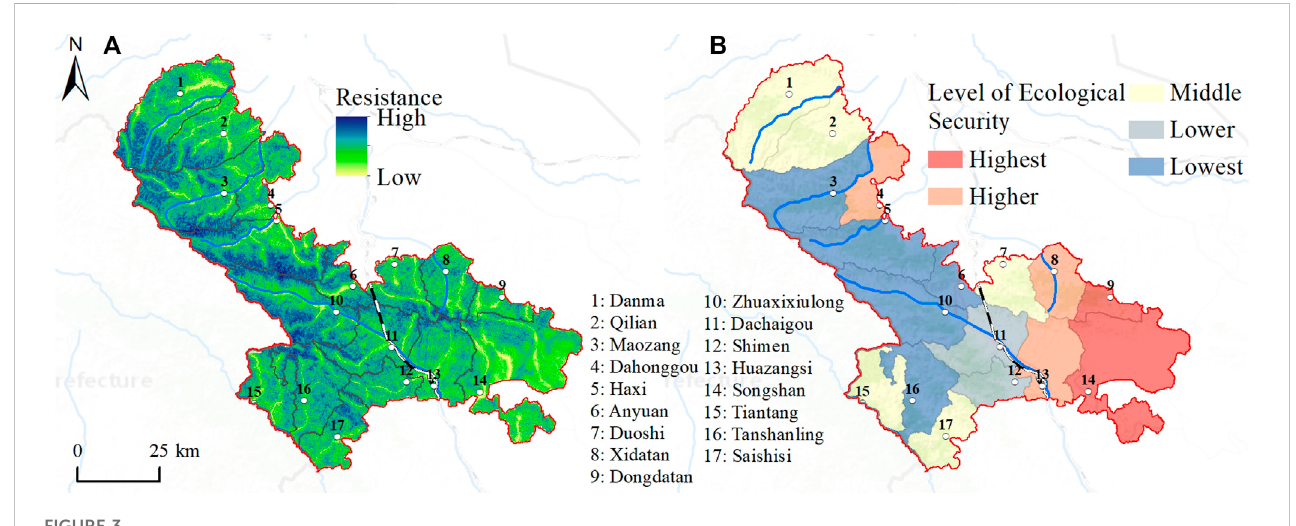
FIGURE 3 (A) Grid map of ecological resistance and (B) classi fi cation of ecological